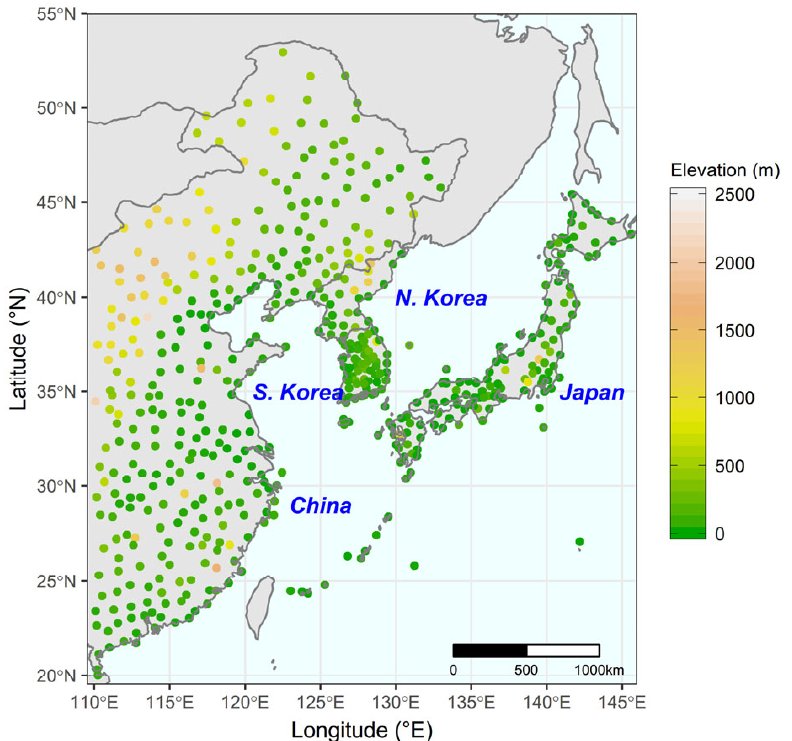
Figure 1. Location and elevation (in unit of meter) of weather stations used in the study over the East Asian monsoon (EAM) region.